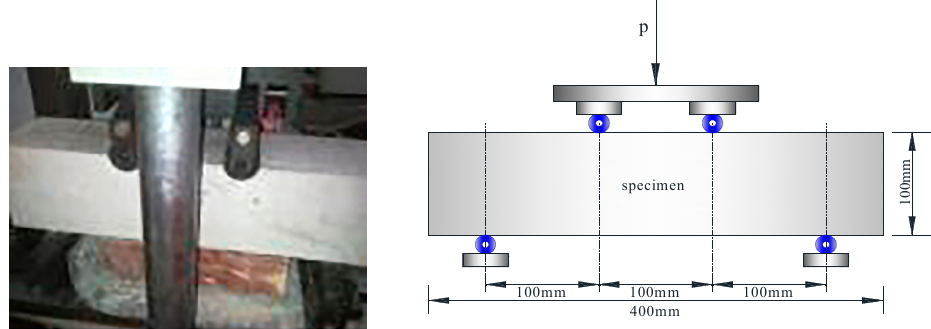
Figure 1. Loading setup of flexural test.